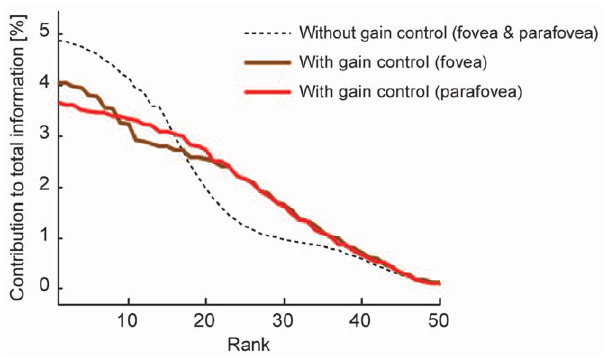
Figure 6. The unit contribution to the total Fisher information carried by the whole population, ranked according to the proportions of contribution. For each unit, we calculated the average of unit-wise Fisher information J Local within { 1 v a v 2 , and then analyzed the averaged contributions for 50 neurons having different preferred spatial frequencies between 0 : 1 v w v 100 , which are the same as those used in the model fitting in Fig. 5. When compared to the case for no neuronal interaction (gray line), the models with response gain control within the hypercolumn suggest more broad distributions of information both in fovea (brown) and parafovea (red). Note the slightly different result between fovea and parafovea when considering gain control among neurons, because the distribution of cell number n w ð Þ affects the a -tuning curves of the individual units.